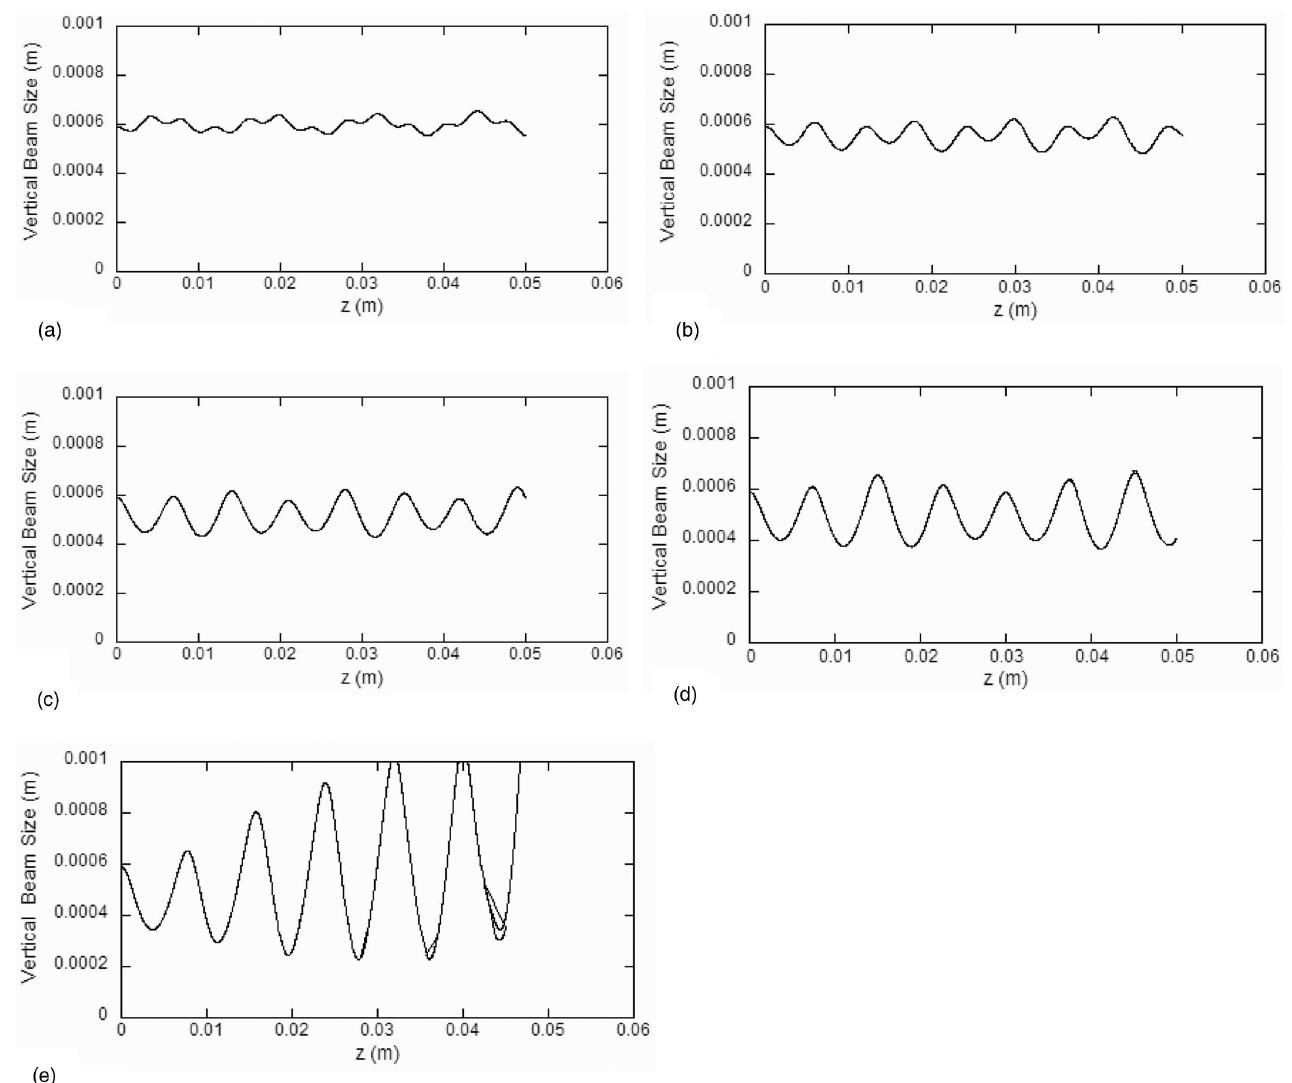
FIG. 10. Vertical beam size for two-plane wiggler focusing, high-emittance case (a) 8-mm period, (b) 12-mm period, (c) 14-mm period, (d) 15-mm period, (e) 16-mm period.